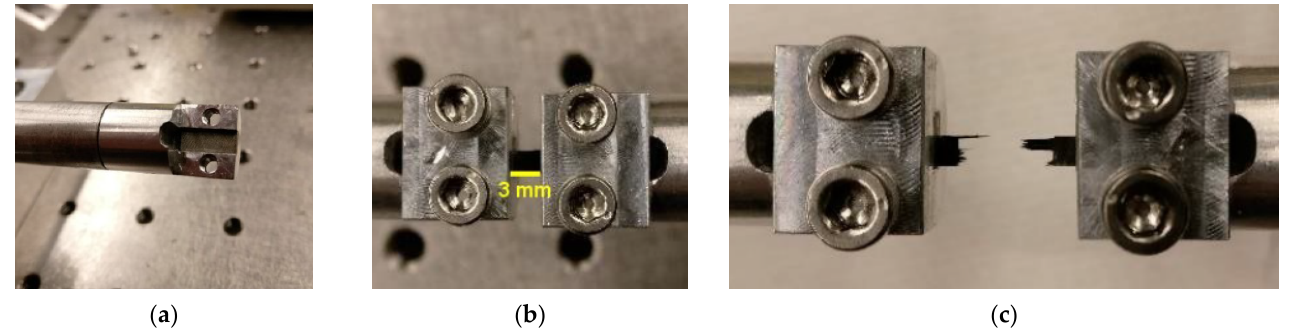
Figure 3. Image of: ( a ) the fixture of the aluminum SHPB that accommodates the specimen, ( b ) the specimen mounted onto the SHPB with a gauge length of 3 mm (prior to the test), and ( c ) tensile fracture of the specimen.